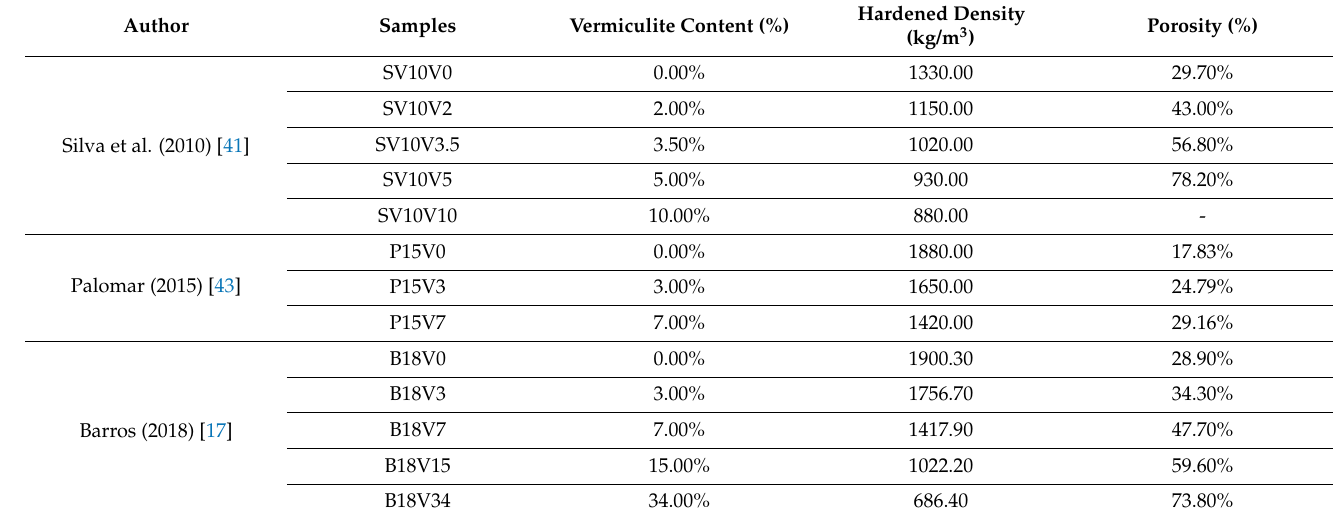
Table 8. Correlation of porosity, hardened density, and vermiculite content